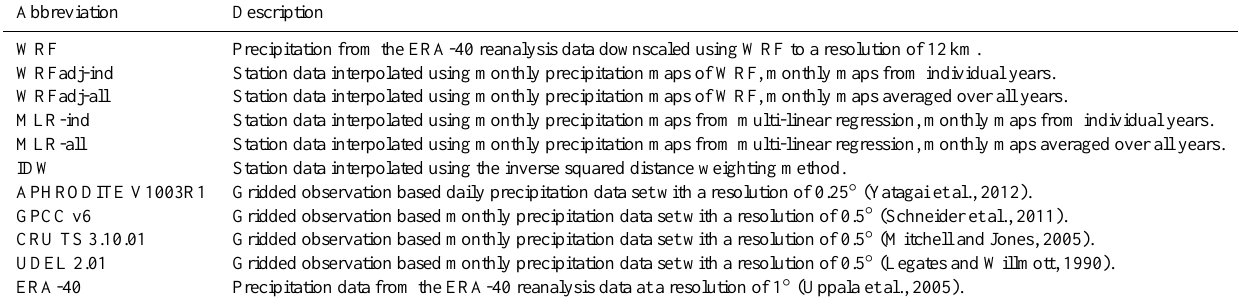
Table 2. Overview of the precipitation data sets used in this